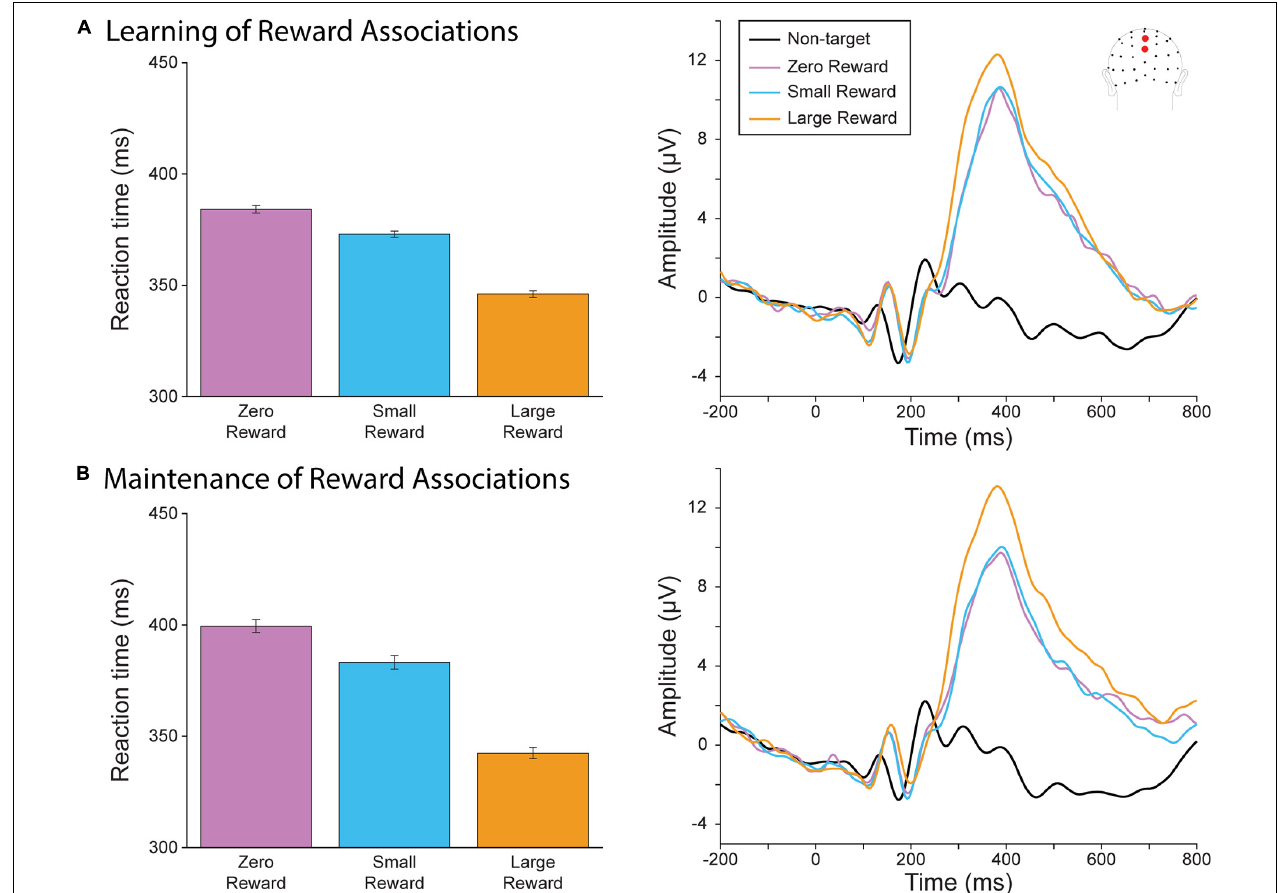
FIGURE 2 | Behavioral and neural results from the reward oddball task. (A) Reaction time ( left ) and P300 ( right) during the learning blocks. Participants responded faster for large-reward targets, which also evoked a larger P300. (B) Reaction time ( left ) and P300 ( right ) during the later, maintenance blocks of the reward oddball task. Similar to the results in the earlier blocks, participants responded faster and had a larger P300 for large-reward